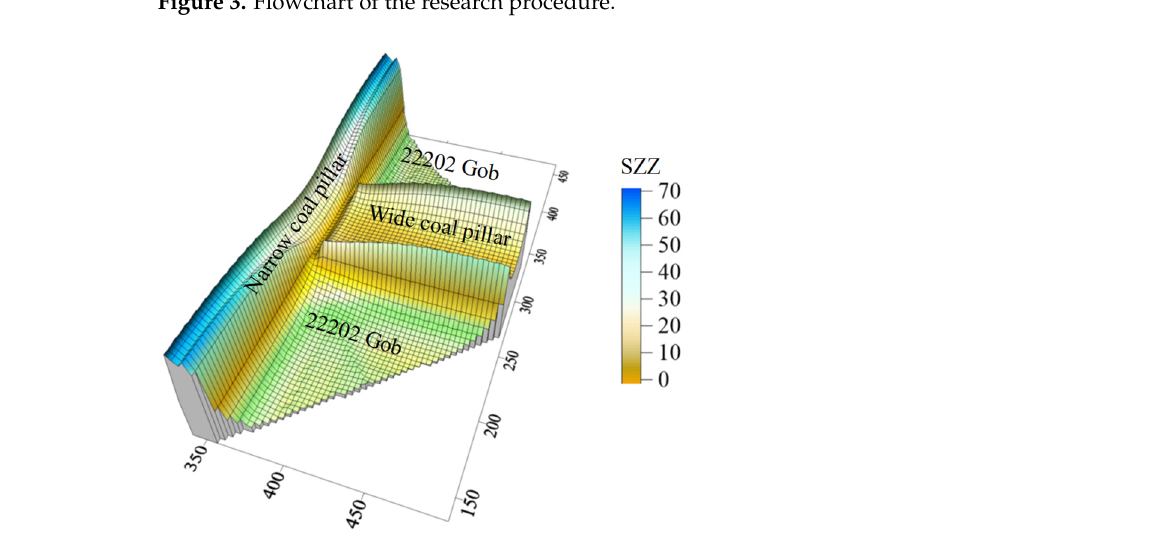
Figure 4. Abutment stress distribution on the T-shaped remaining coal pillar in the 2-2 coal seam.